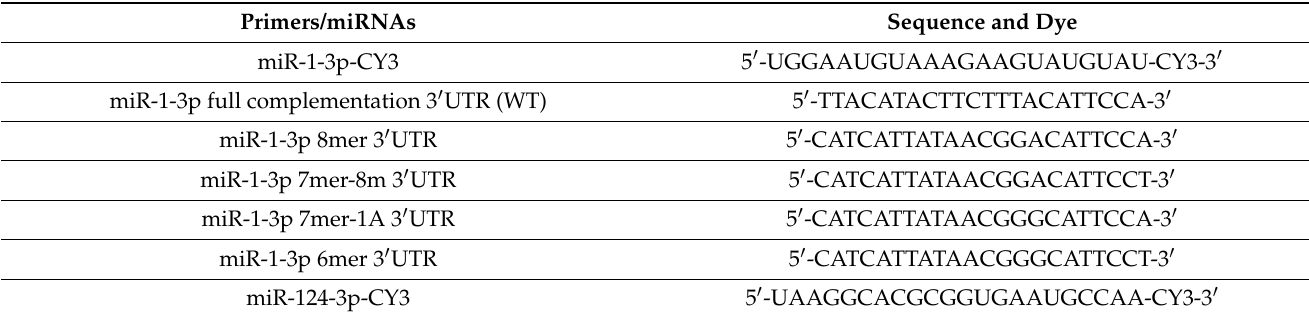
Table 1. Mature miRNAs or 3 (cid:48) UTR canonical site